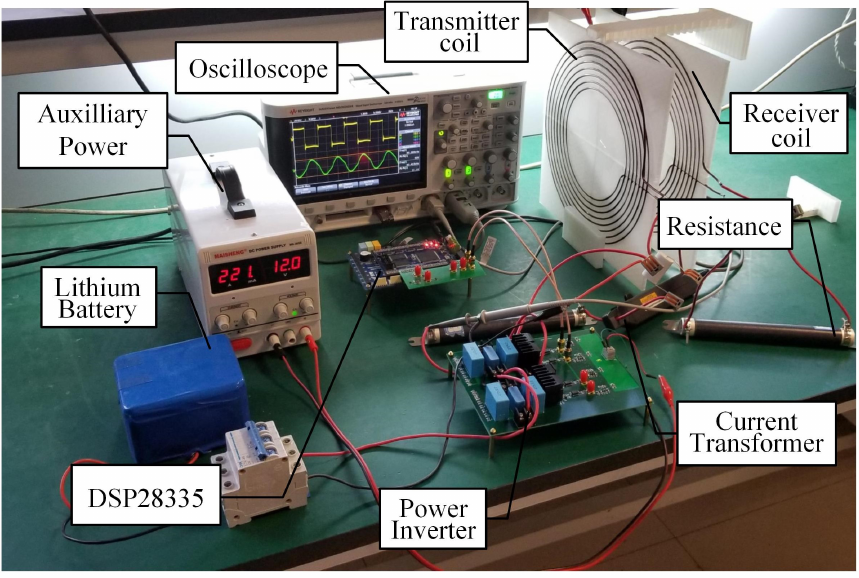
Figure 9. Experimental